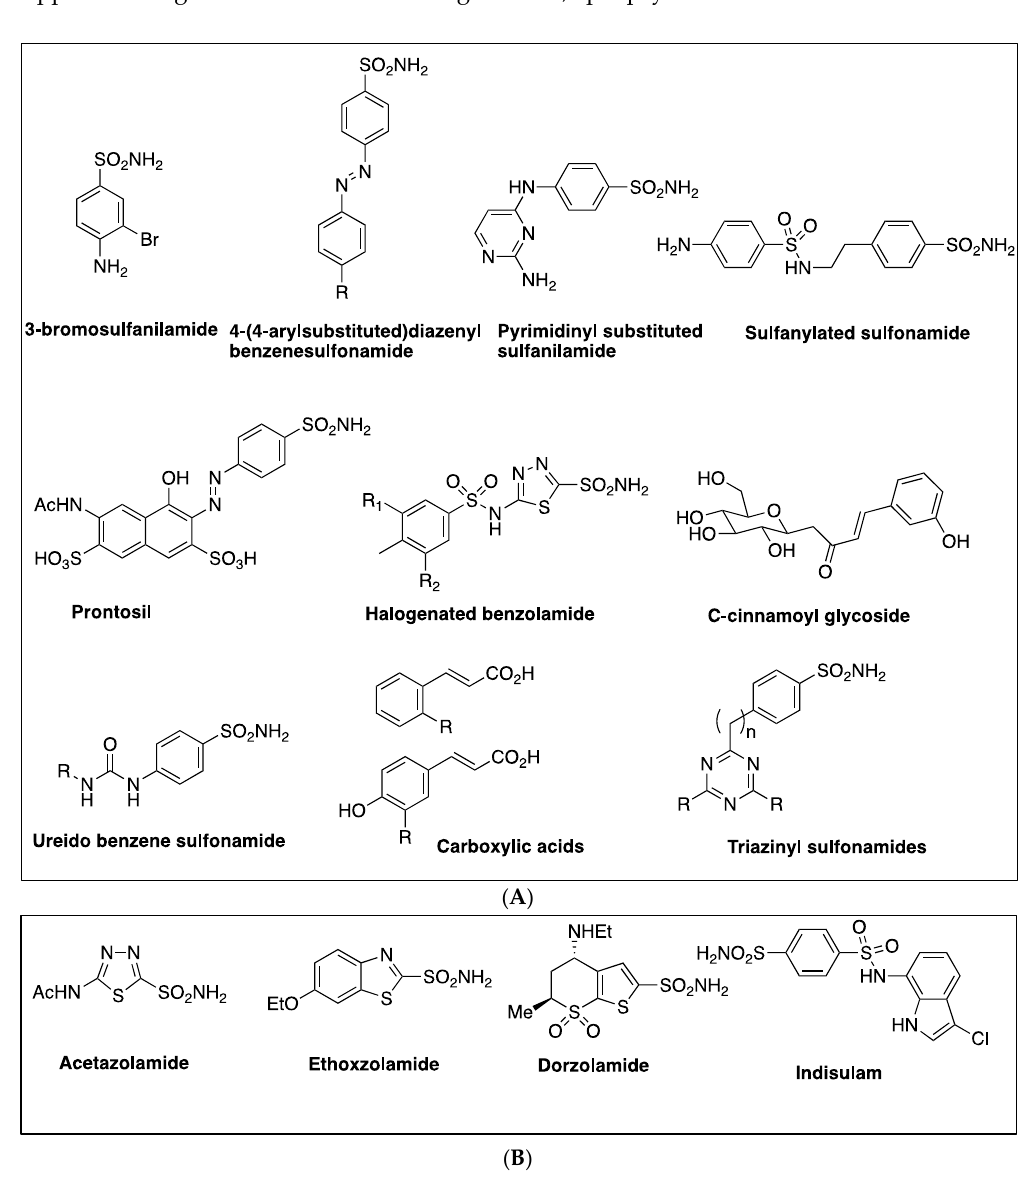
Figure 10. Novel compounds that inhibit M. tuberculosis β -CAs at nanomolar quantities. ( Upper panel ; A ): structures of the compounds with a potential to be developed as anti-mycobacterial agents for treating the mycobacterial diseases caused by MTC and NTM bacteria that are resistant to clinically used drugs. ( Lower panel ; B ): compounds that efficiently inhibit the M. tuberculosis β -CAs in addition to human CAII and are in clinical use or testing to treat human diseases.